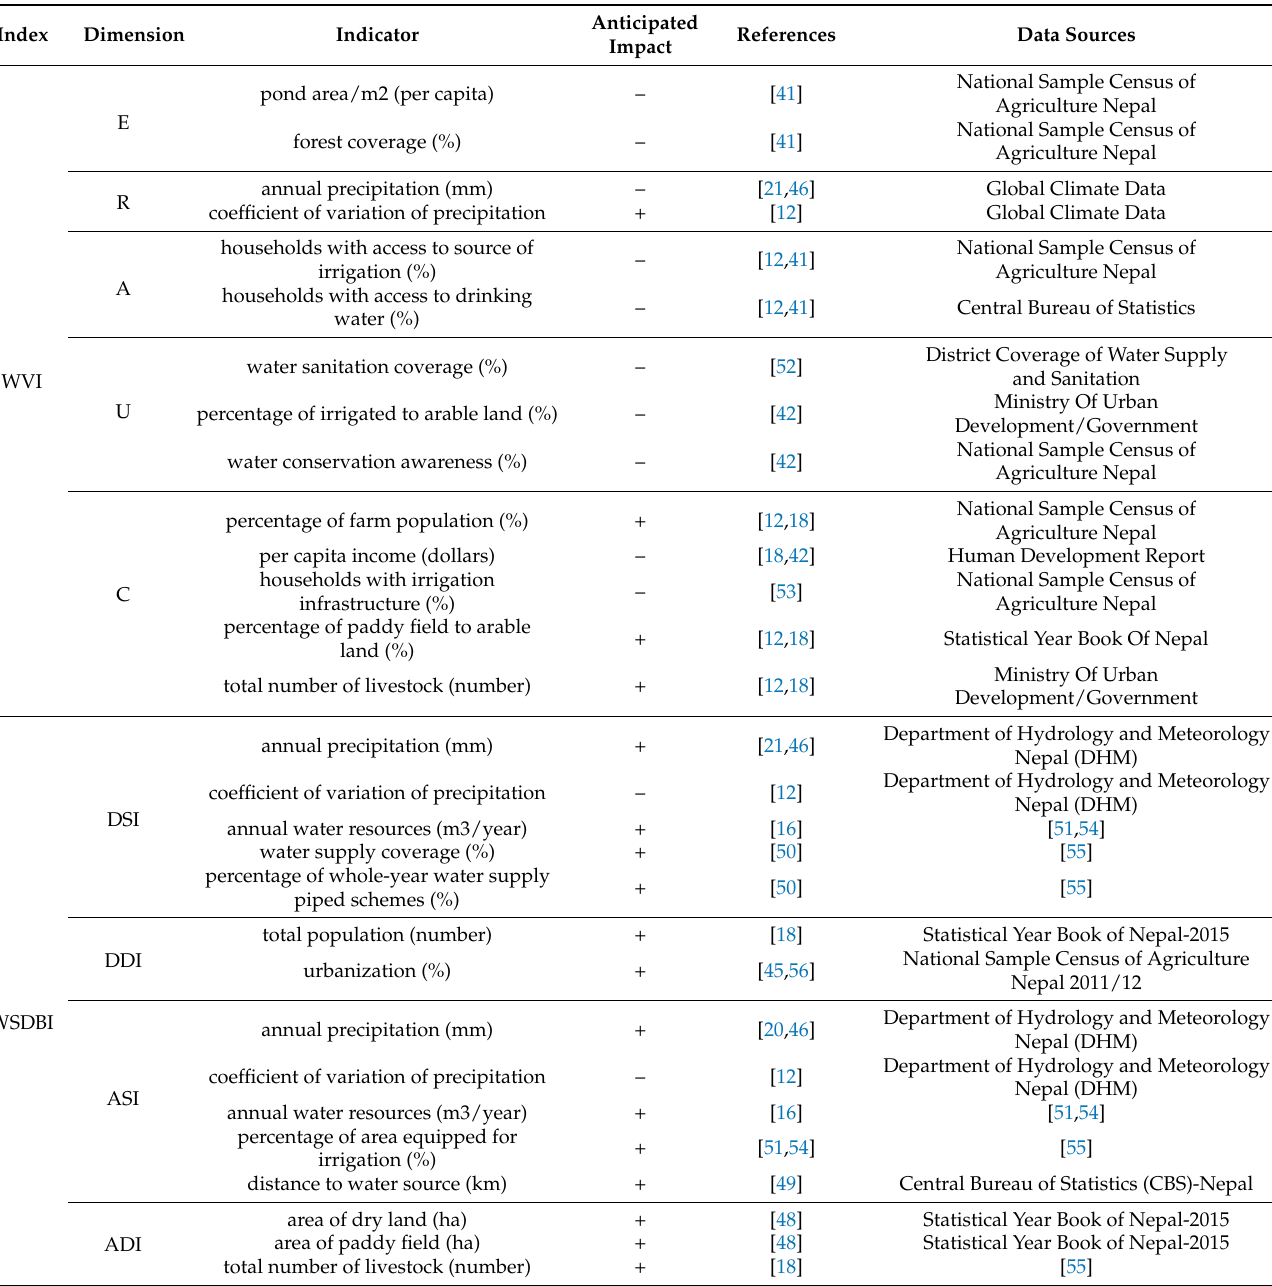
Table 1. Primary variables used in the water vulnerability model and water supply-demand balance